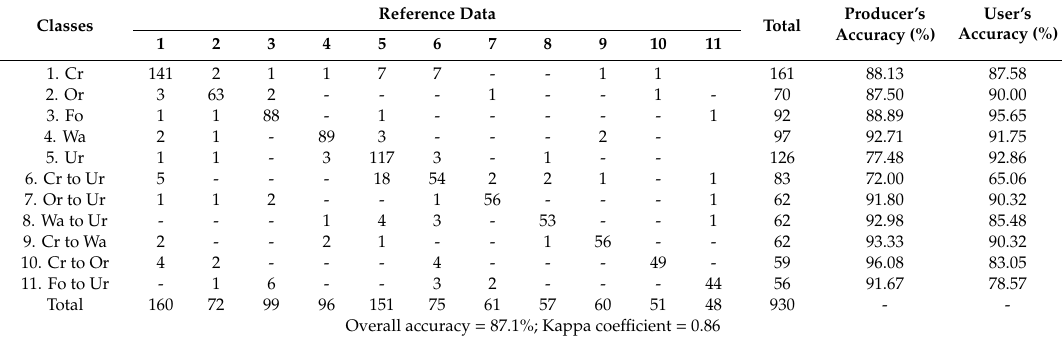
Table 8. Confusion matrix of the post-classification method, 2000–2003.